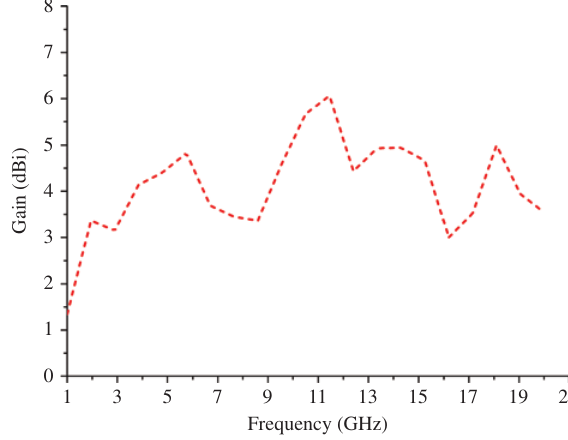
Figure 8: Measured gain of this reported